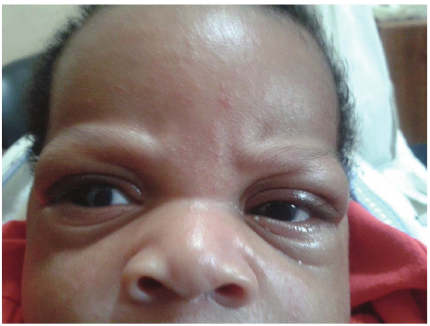
Figure 4: Spontaneous opening of the eyes on the third